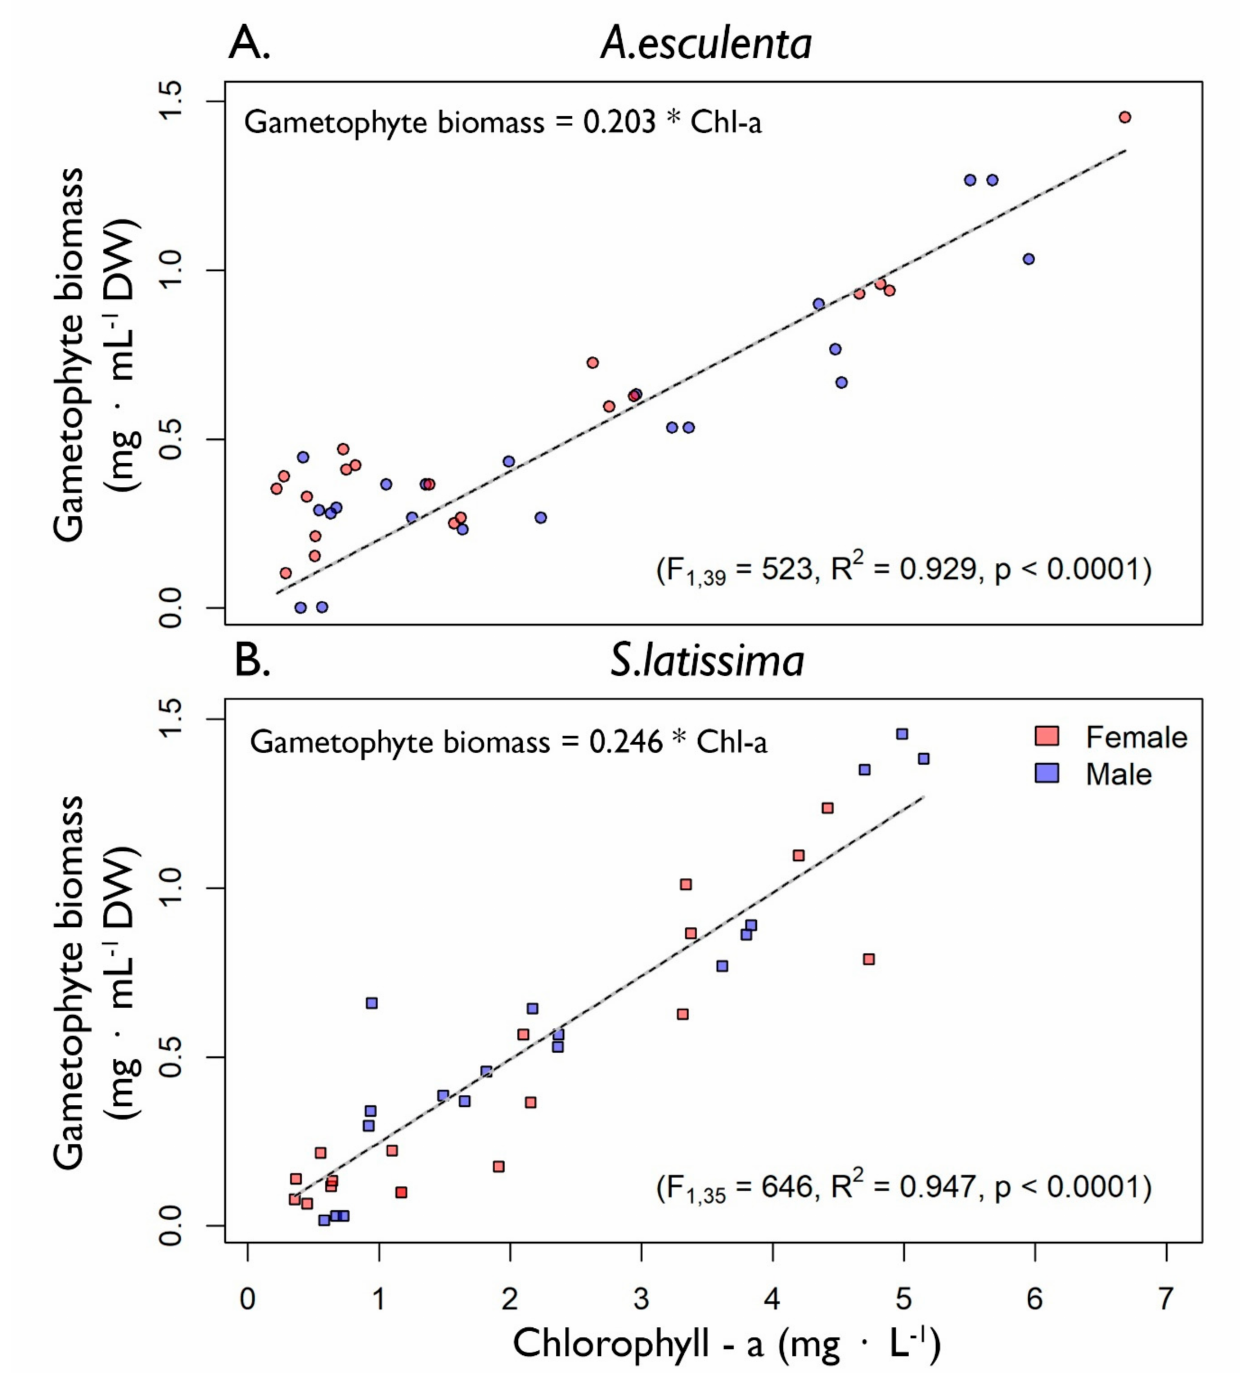
Figure 1. Chlorophyll a concentration (mg · L − 1 Chl; x-axis) versus initial gametophyte density (mg · mL − 1 DW; yaxis) of A. esculenta ( A ) and S. latissima ( B ) and the corresponding calibration